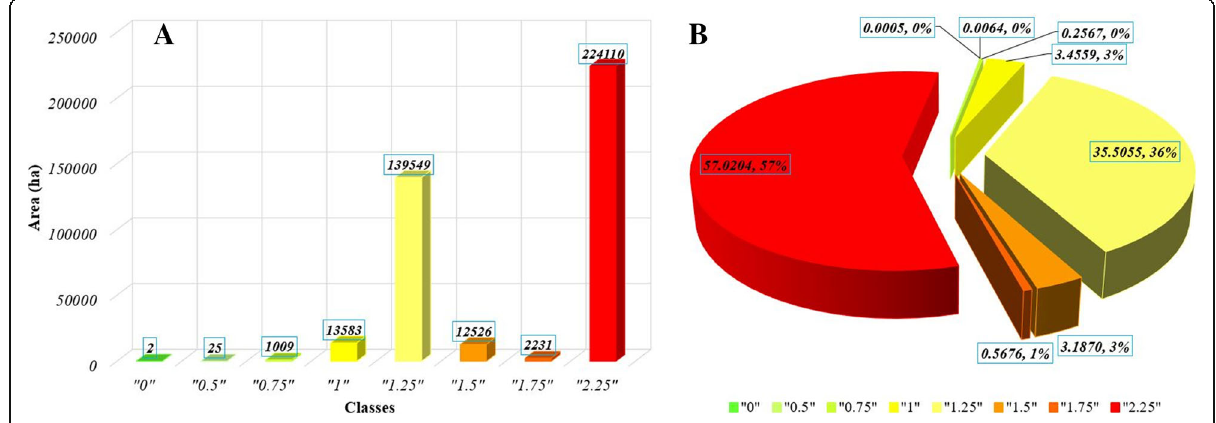
Fig. 11 Areas ( A ) and percentages ( B ) of LHZ per classes